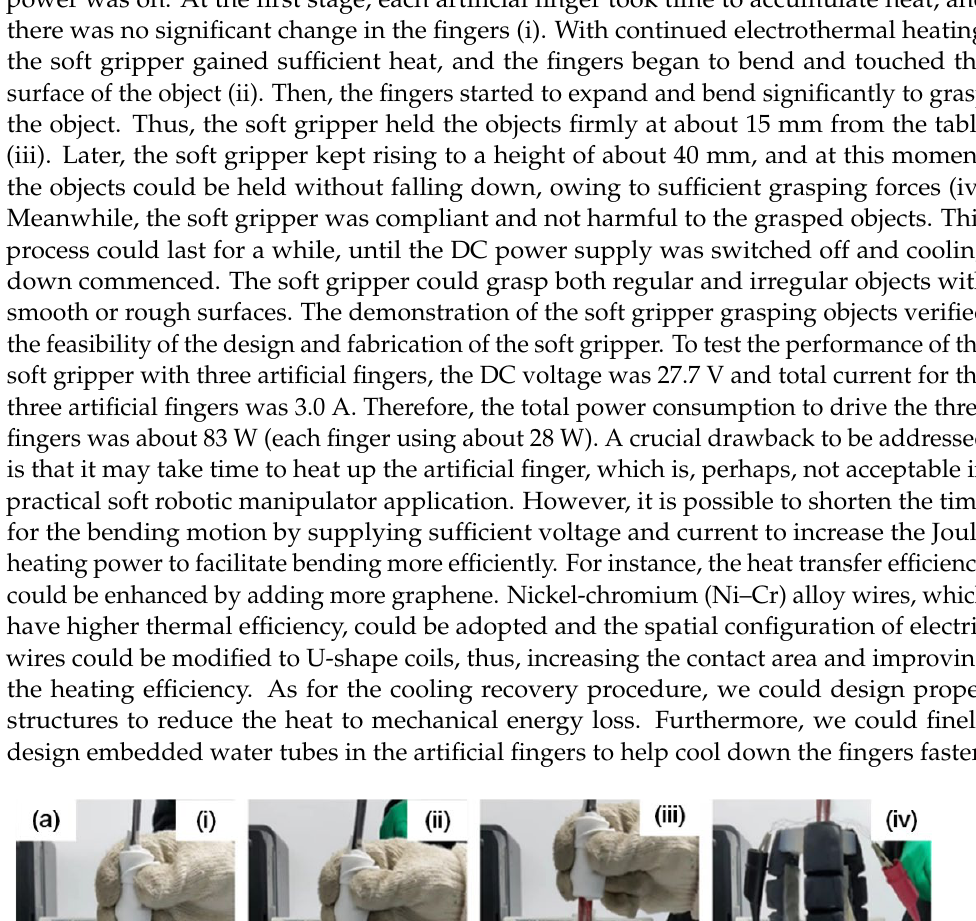
Figure 7. Demonstration of grasping objects ( a ) shuttlecock, ( b ) tennis ball and ( c ) glass beaker with the as-prepared soft gripper. ( i – iv ) indicate the initial state, bending starting and touching the objects, holding the objects and lifting the objects, respectively. 4. Conclusions In summary, a soft gripper was presented with three artificial fingers made with tri- layer polymeric structures. The three functional layers were prepared by molding and pressing, and their mechanical or rheological properties were investigated. The actuation